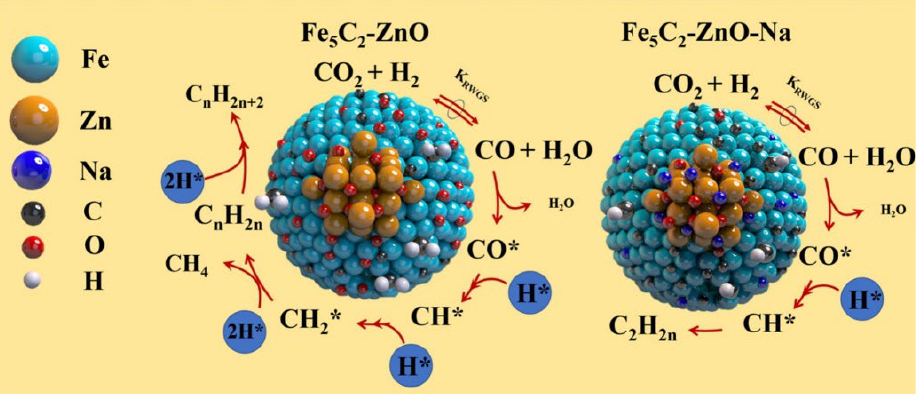
Figure 4. Plausible mechanism of Na effects on Fe 5 C 2 for CO 2 hydrogenation. Reprinted with permission from ref. [94]. Copyright 2021 Elsevier.